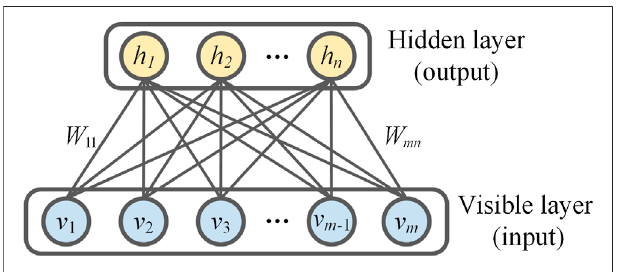
FIGURE 1 | Structure of an restricted Boltzmann